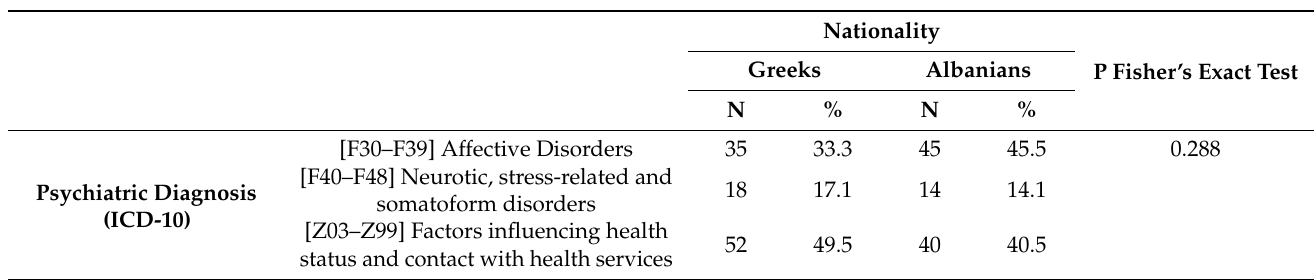
Table 2. Psychiatric